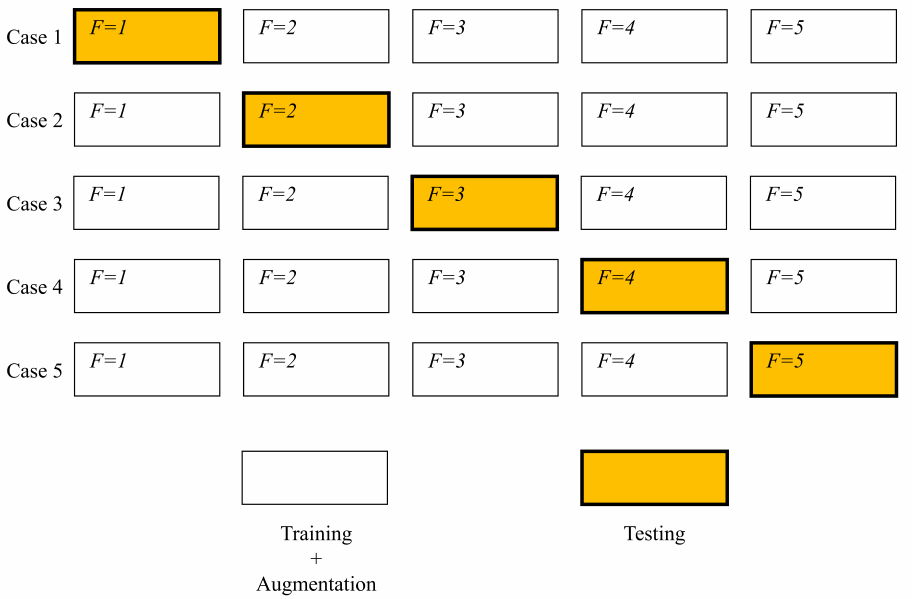
Figure 6. Illustration of a cross-validation procedure adapted for GAN-based